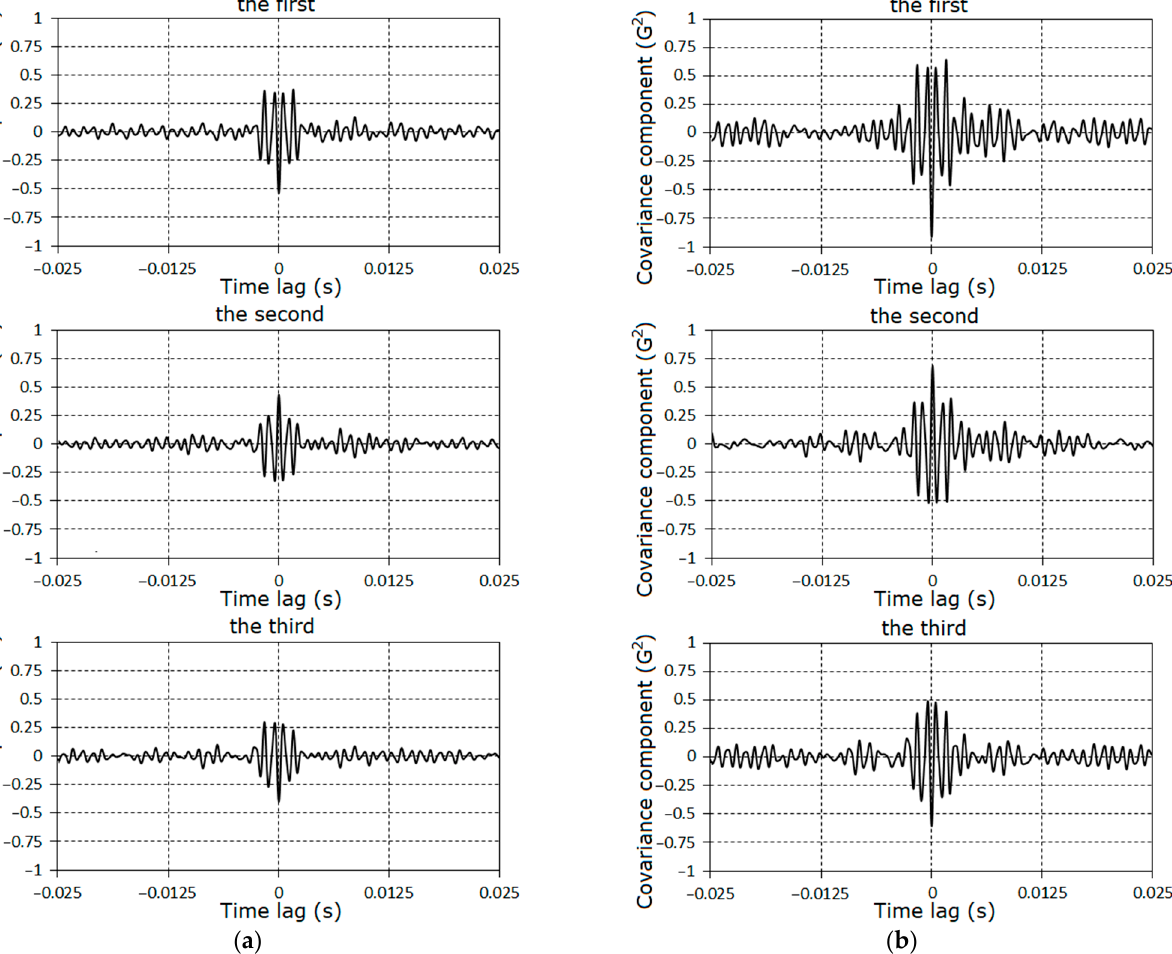
Figure 19. The dependences of the first, second, and third cosine covariance components estimators on starting lag for the second ( a ) and third ( b ) stages.